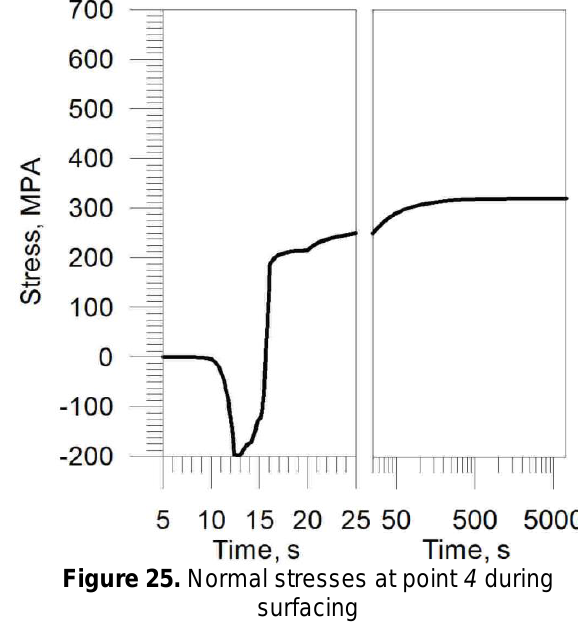
Figure 25. Normal stresses at point 4 during